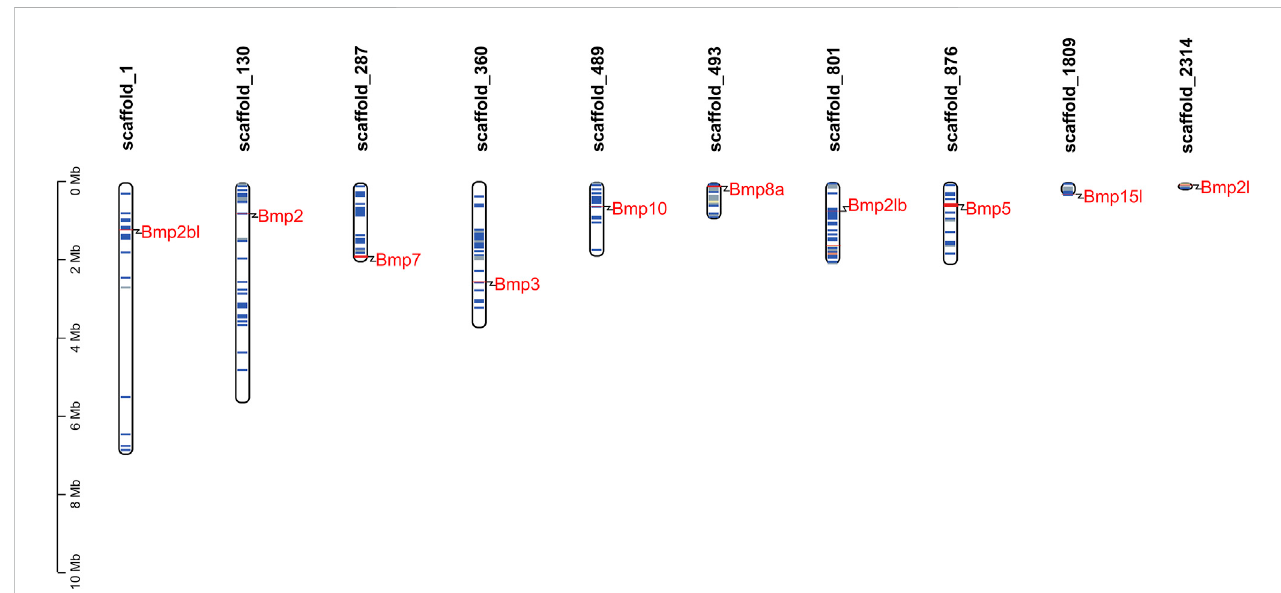
FIGURE 3 Scaffold distribution of BMP genes in P . sinensis . The blue lines represent gene density of scaffolds, and the red lines indicate higher gene density. The gene density is de fi ned as the number of genes within a 50 kb genome.